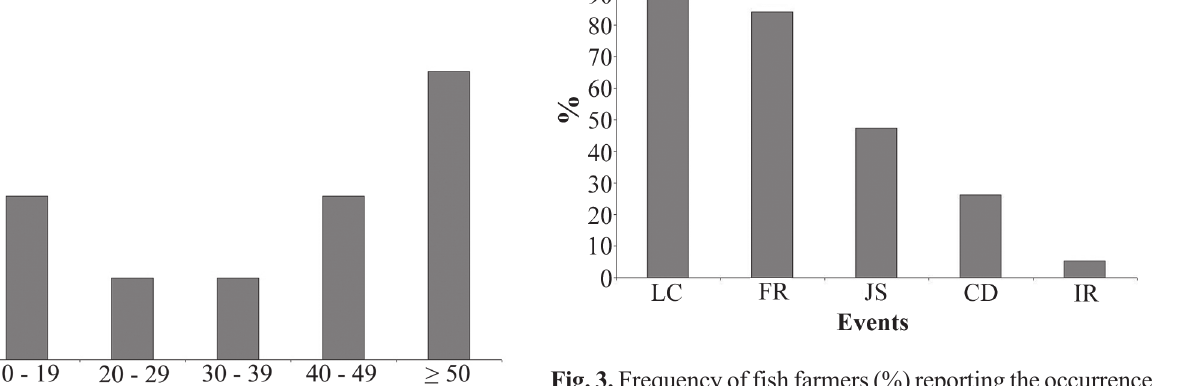
Fig. 3. Frequency of fish farmers (%) reporting the occurrence of fish escapes during different events of the production chain (n = 19). Accidental: length classification (LC); fish removal (FR); juvenile stocking (JS); cage damage (CD). Deliberate: intentional releases